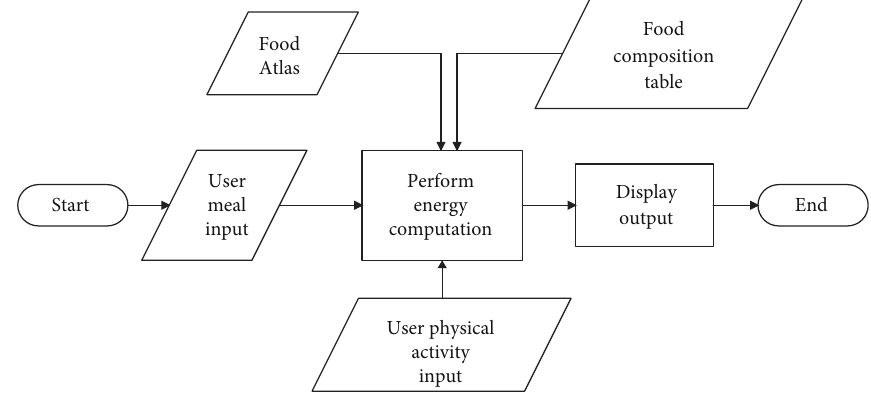
Figure 2: Flow diagram of the calorie extraction and estimation operation.